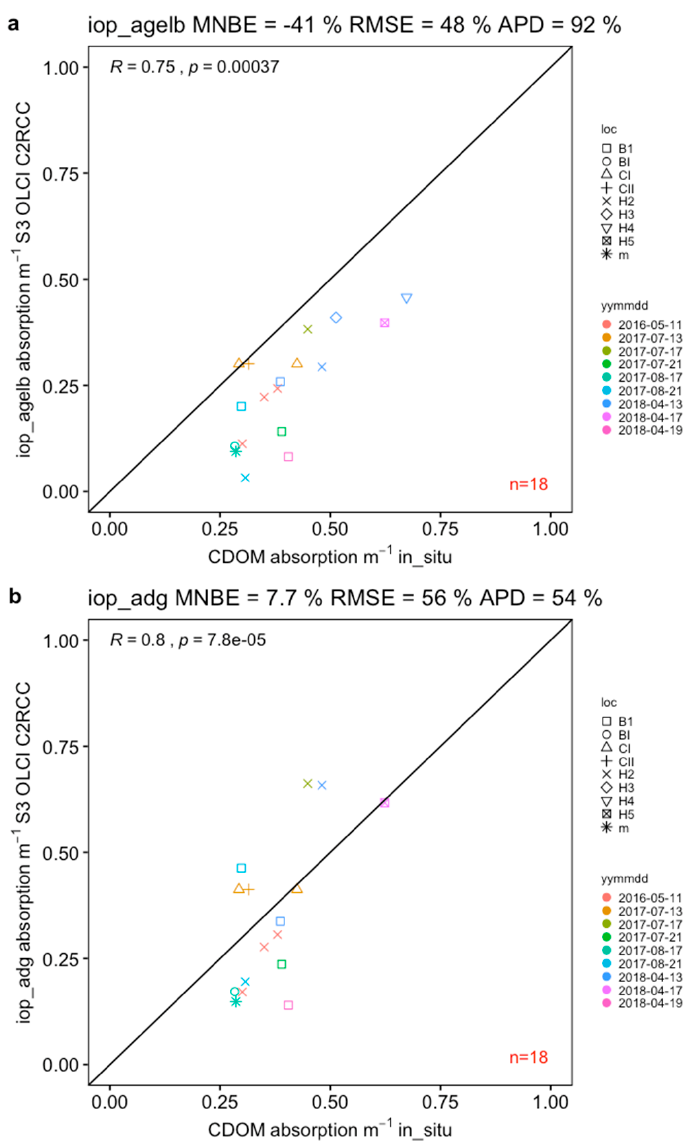
Figure 6. Absorption coefficient of ( a ) Gelbstoff at 443 nm (iop_agelb) and ( b ) detritus + gelbstoff absorption at 443 nm (iop_adg) derived from S3A OLCI using C2RCC-SNAP both compared to in situ absorption of CDOM, a CDOM (440).